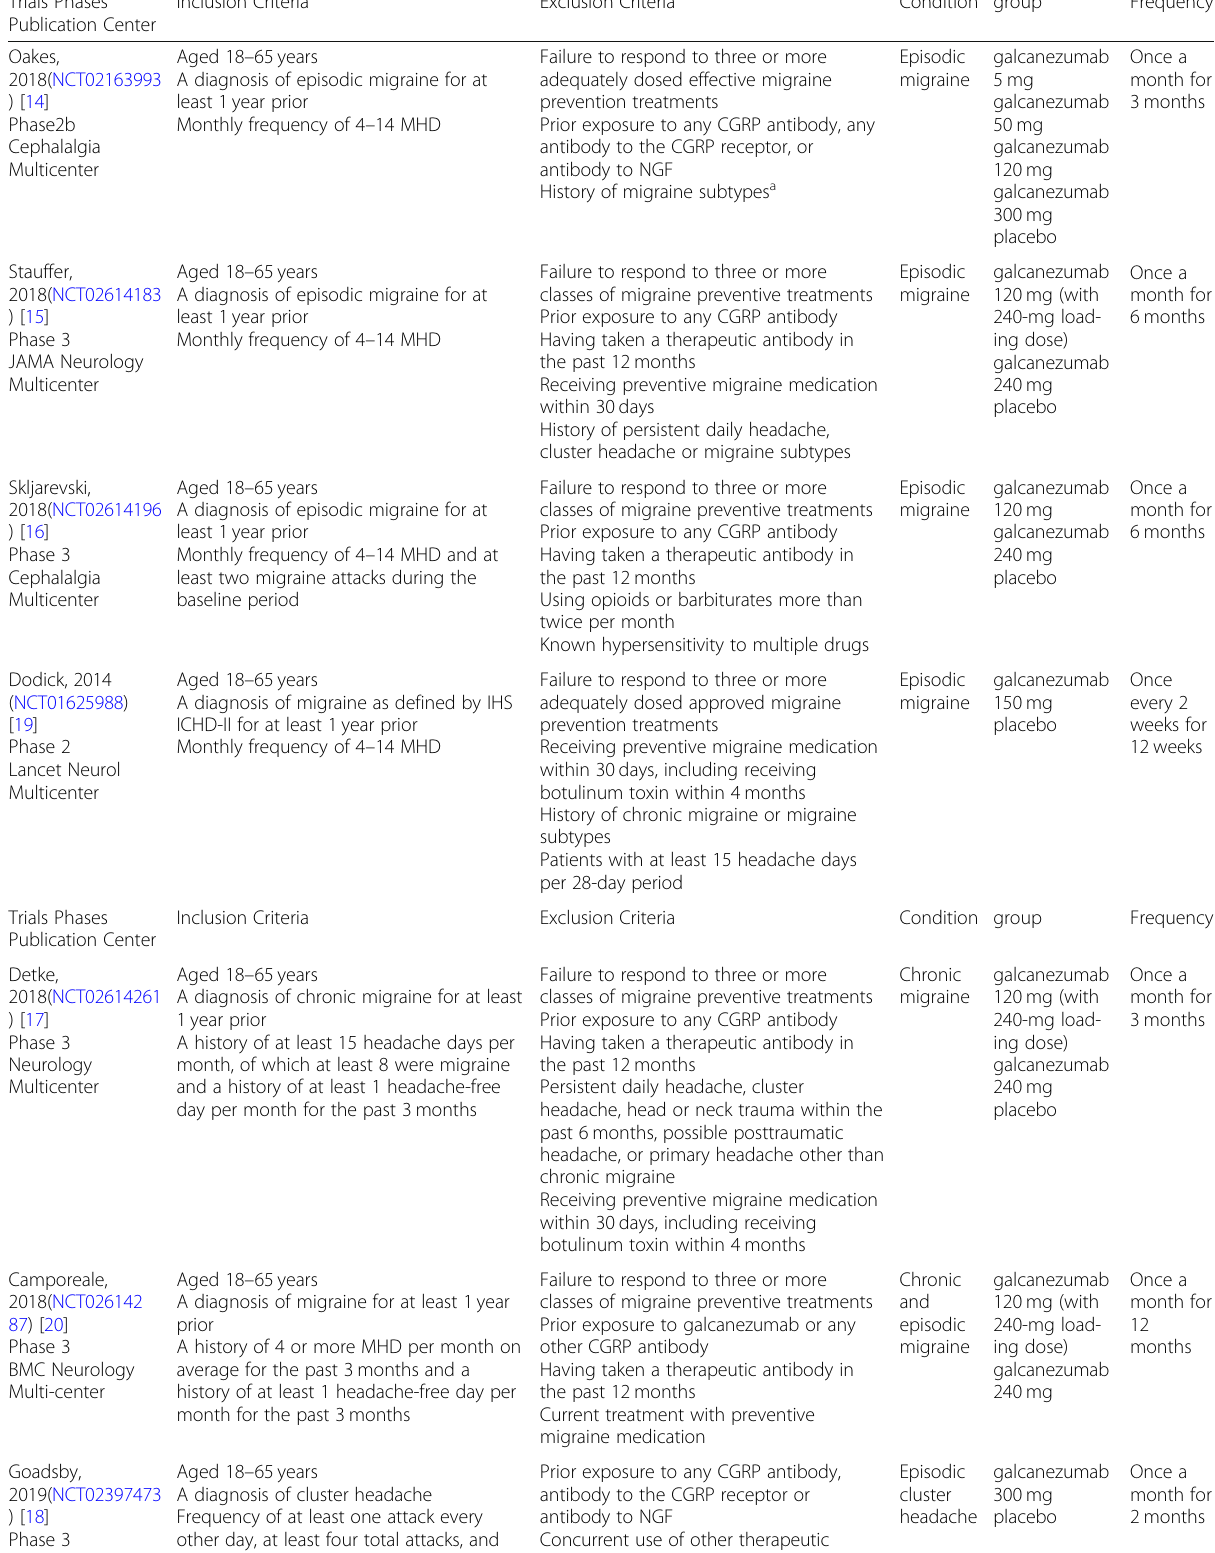
Table 1 Characteristics of the Included Studies and Outcome